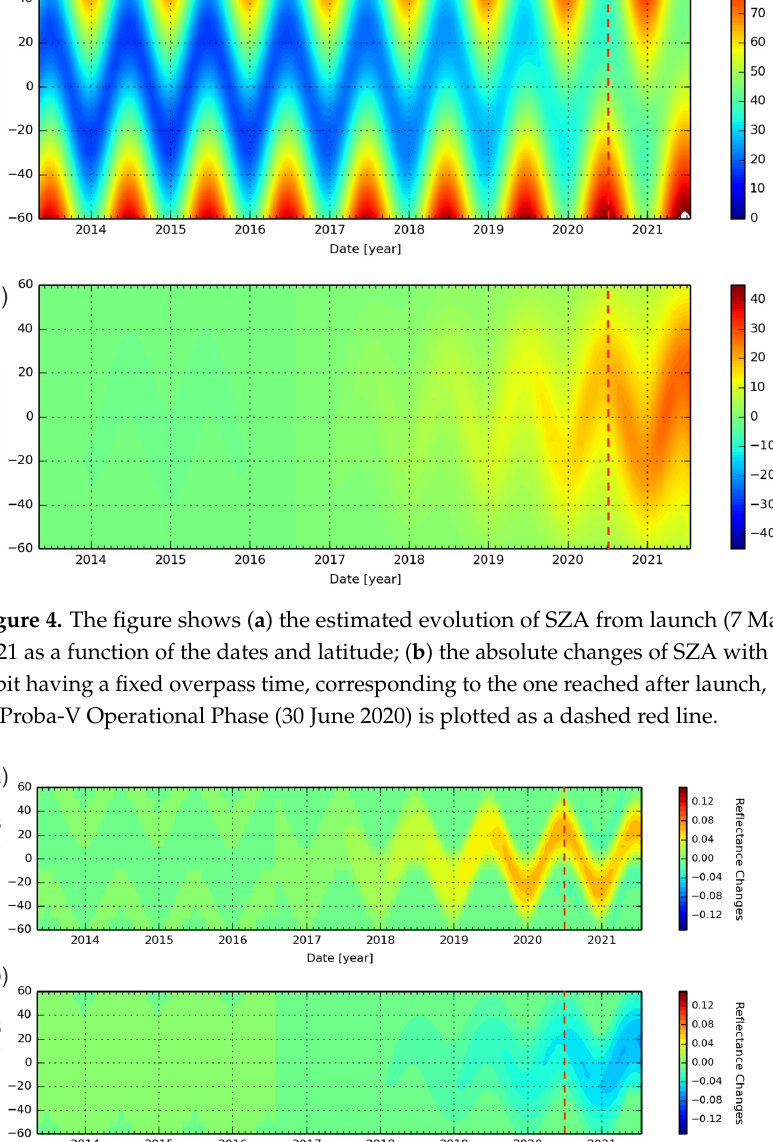
points to the eastward direction (towards the sun).